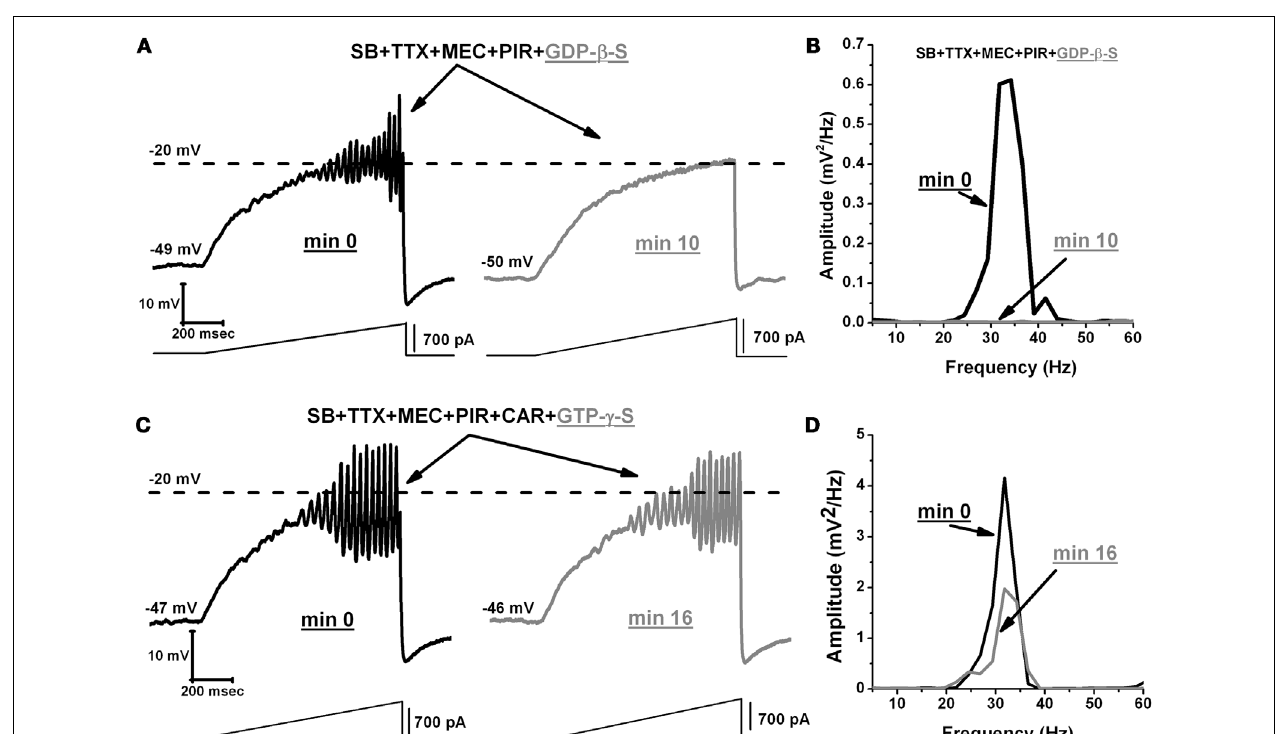
the presence of SB + TTX + MEC + PIR + CAR following rupturing the membrane (left record, black). Note that activation of G-proteins by GTP- γ -S did not decrease or further increase the frequency of oscillations (right record, gray). (D) Power spectrum of the records in C showing that high frequency oscillation frequency remained similar before (black line) vs. after (gray line) GTP- γ -S. (Abbreviations: CAR, carbachol; SB, synaptic blockers;TTX, tetrodotoxin; MEC, mecamylamine; PIR,